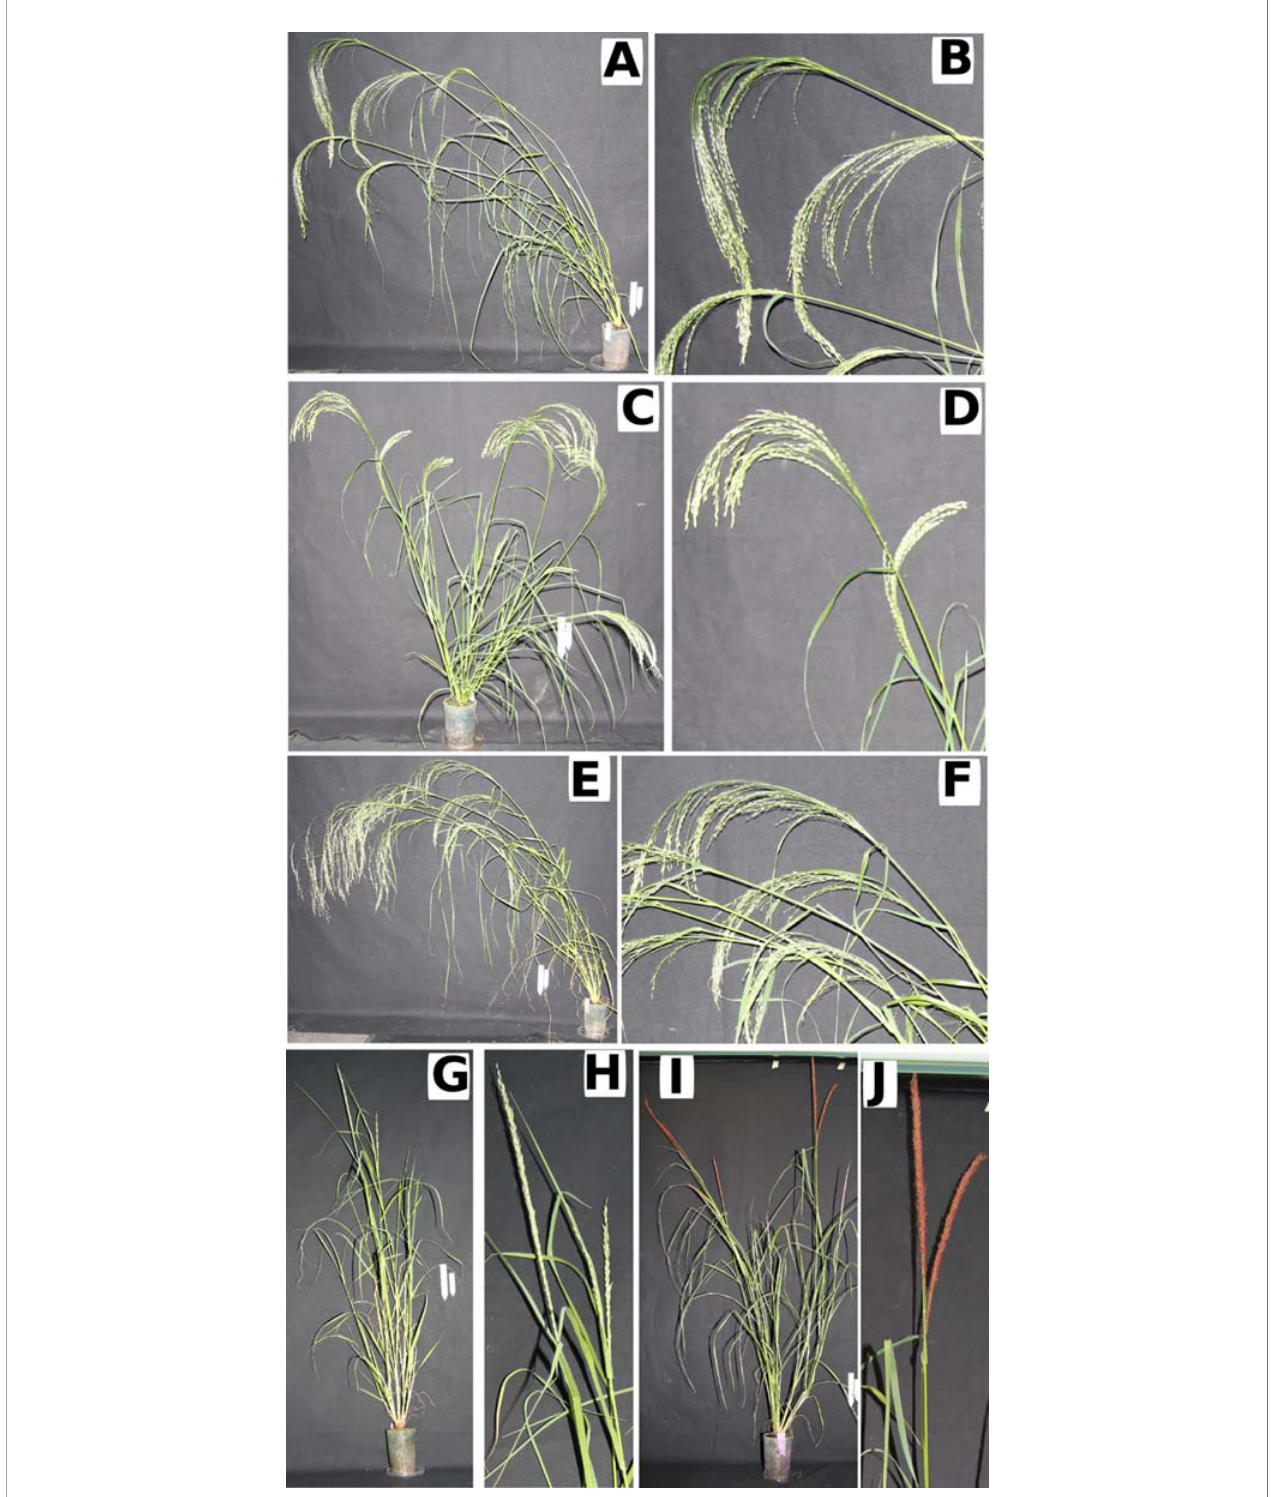
FIGURE 1 | The tef genotypes differ in their overall morphology and the panicle morphology. (A , B) Dukem ; (C , D) Gommadie ; (E , F) kinde ; (G , H) Key Murri ; (I , J) Quncho . (A , C , E , G , H) Whole plant, (B , D , F , H , J) close up of panicles. Scale bar 10 cm.